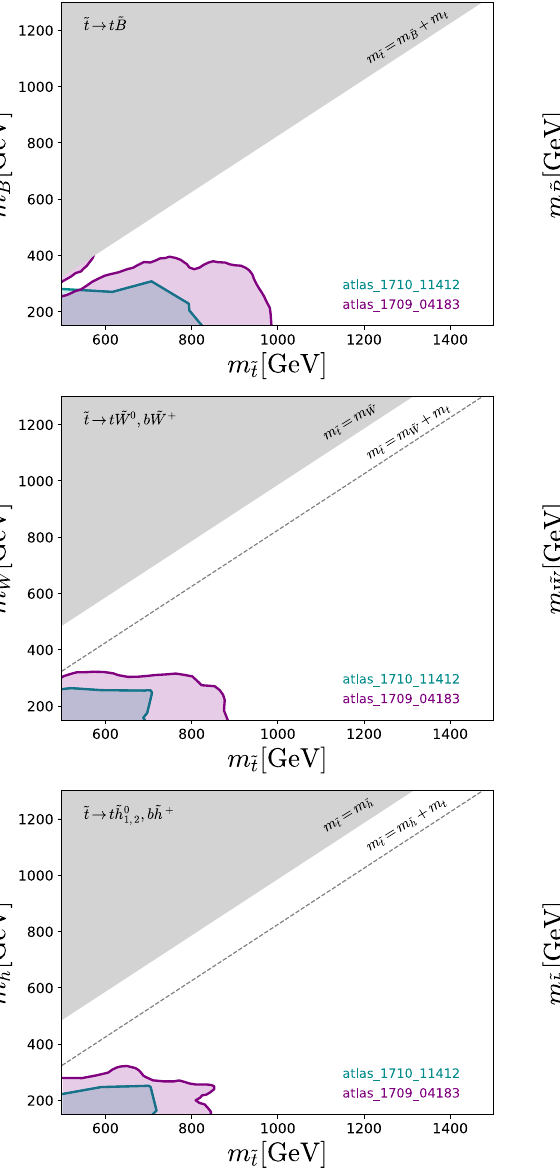
Figure 3 . The exclusion plots in the stop model, section 4.1. The left column with electroweakino as the LSP and the right column with gravitino LSP. From top to bottom: bino, wino and higgsino case. Only the most constraining analyses are